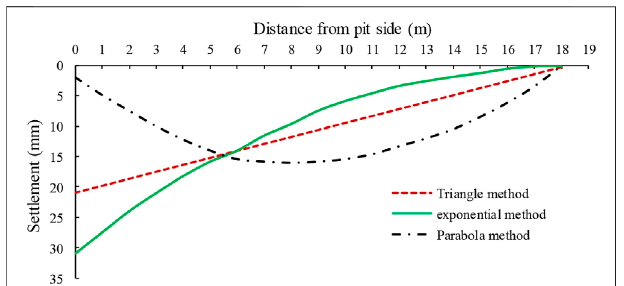
FIGURE 3 | Ground settlement distributions away from pit